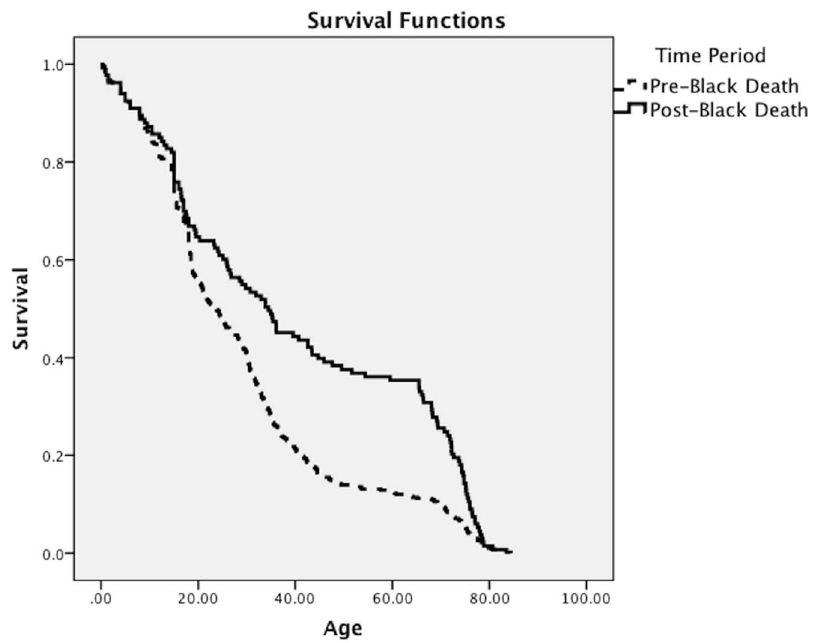
Figure 2. Kaplan-Meier survivorship functions for the pre- and post-Black Death samples.